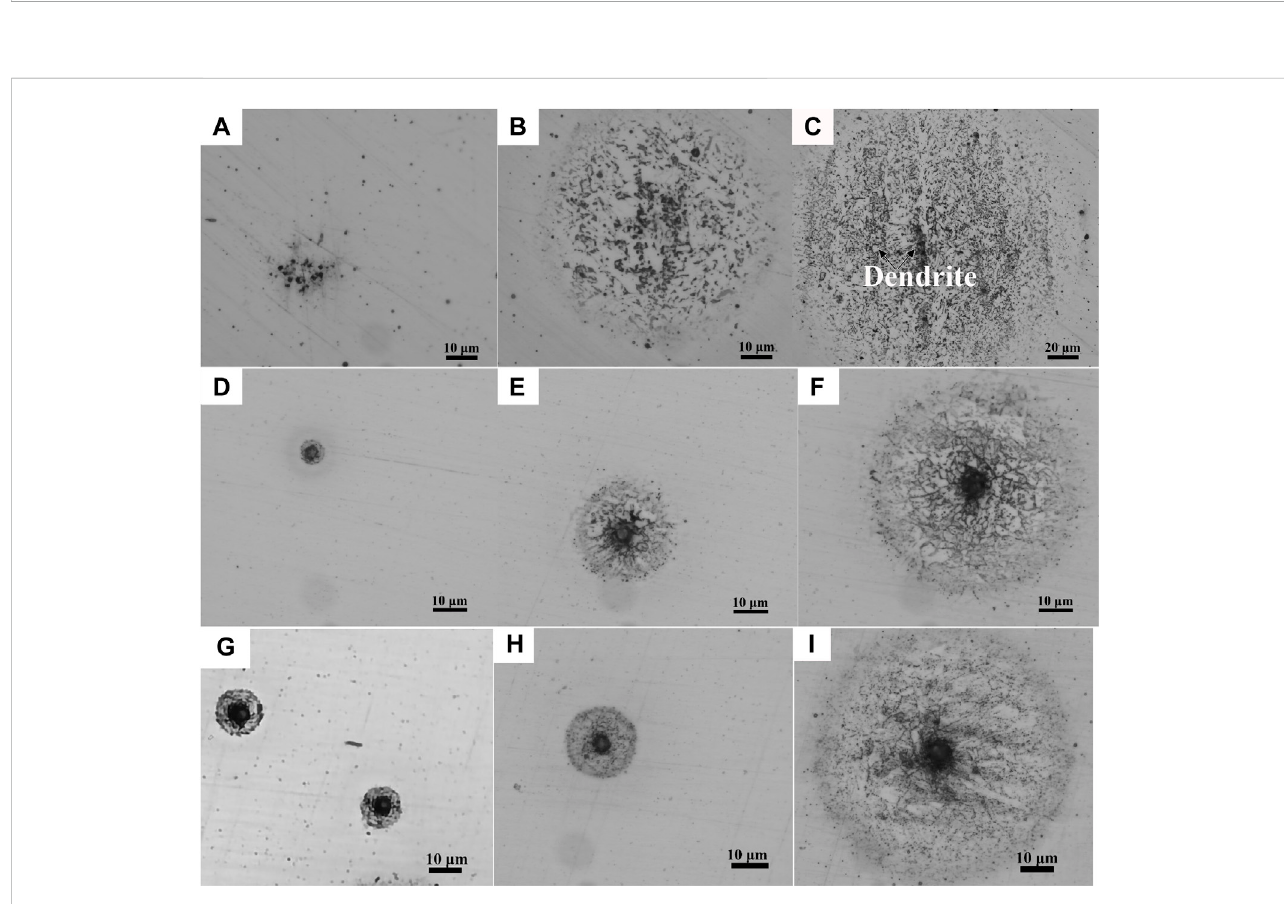
FIGURE 8 OM images of pitting corrosion in different stages: (A – C) WM 2 ; (D – F) FGHAZ; (G – I) BM.